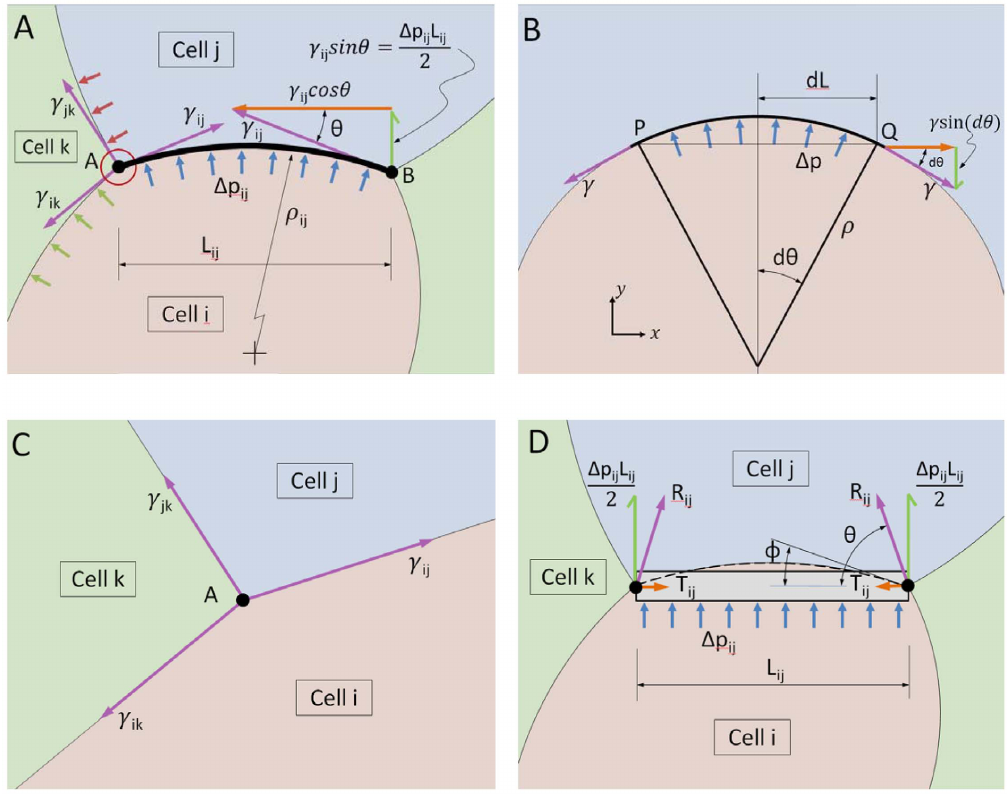
Figure 2. Equilibrium considerations. ( A ) shows a curved cell edge and the forces acting on it, while ( B ) shows how edge tension, curvature and pressure are related. Specifically, the pressure difference D p generates a force F y ~ 2 D p dL ~ 2 D p r d h in the y -direction. This force must be just balanced by the vertical components of the tension c . Thus we have that 2 D p r d h ~ 2 c sin( d h ) % 2 c d h which, when simplified, gives D p ~ c = r , the Laplace equation. ( C ) shows the forces that act at a typical triple junction, while ( D ) shows the forces that act on an edge that is constrained to remain straight by beam action, as described in the text.